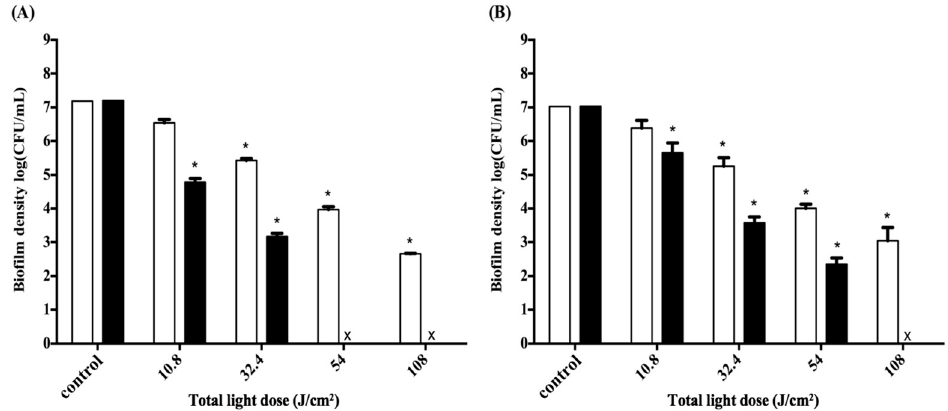
Figure 5. Cell survival fraction of Aggregatibacter actinomycetemcomitans ( A. actinomycetemcomitans ) ( A ) and P. gingivalis ( B ) biofilms in a 3D gingival model after incubation with F-2 for 0.5 h, and subjected to various doses of light illumination from four sides. After PDI, biofilm maintained contact with F-2 for 0.5 h ( ☐ ) and 2 h ( ) prior to plate count. Each value is the mean of three independent experiments ± standard deviation. * p < 0.05.